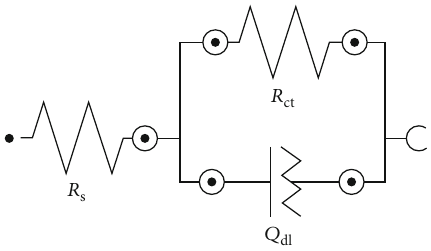
Figure 13: Equivalent circuit R ð RQ Þ fi tted on EIS results for extract Table 6: Values of parameters obtained through attribution of EIS results to equivalent circuits.